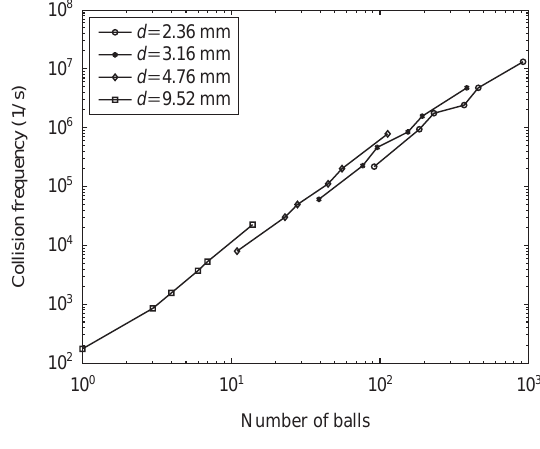
Collision frequency (1/s) in the system as a function of number of milling balls for different ball